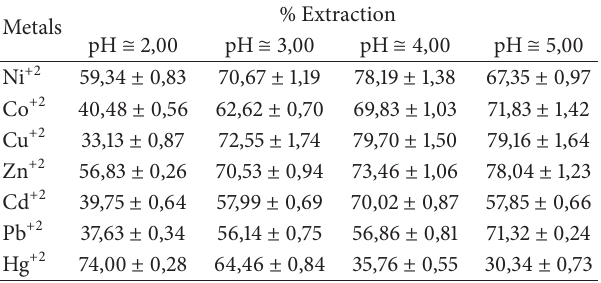
Table 5: Extraction of metal cations with L4 (%).